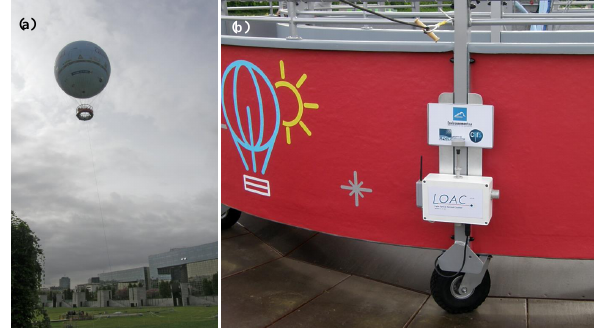
Figure 7. LOAC on the recreational OAG tethered balloon in Parc André Citroën, Paris. (a) View on the balloon in flight; (b) view of the LOAC installed in a small box on the side of the passenger gondola with its TSP inlet above, a small WiFi antenna on the left of the box for data transmission, and a ventilation opening protection (grey) on the